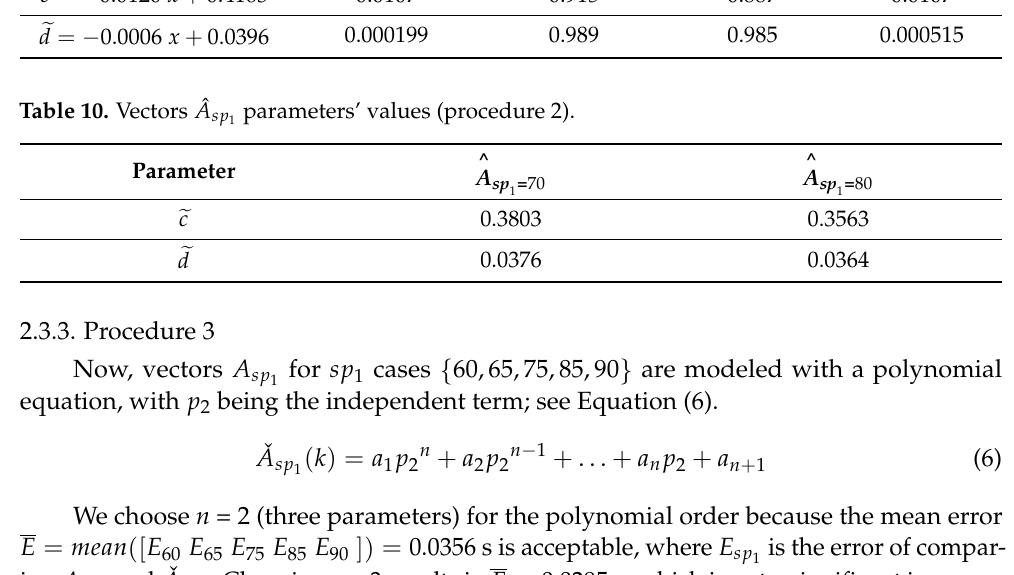
Table 10. Vectors ˆ A sp